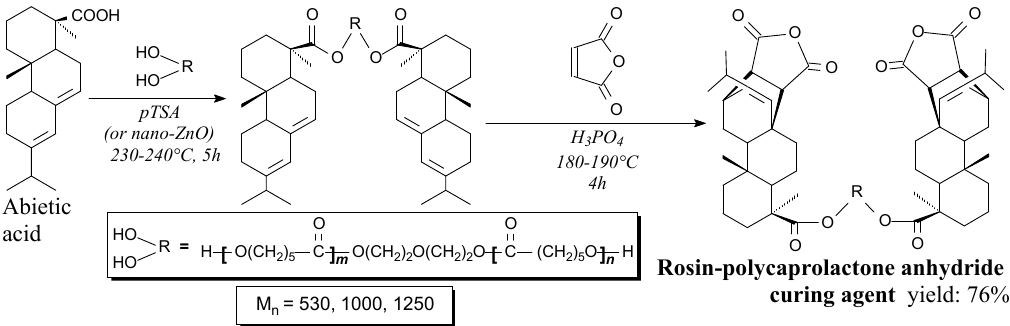
Scheme 24. Synthesis of rosin-polycaprolactone anhydride curing agent.